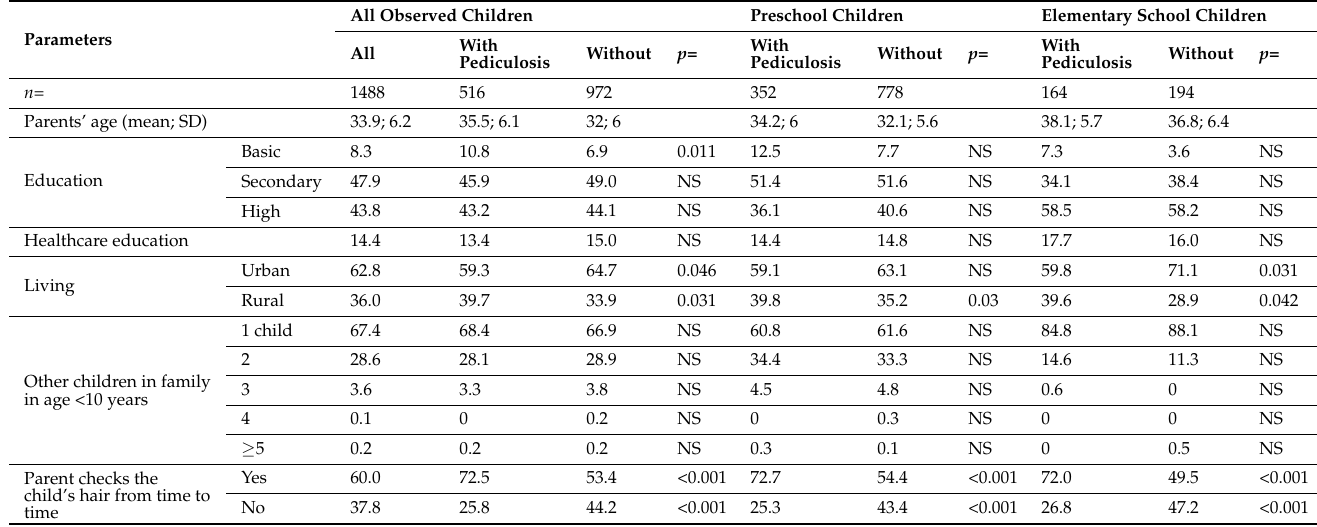
Table 1. Sociodemographic data and basic pediculosis prophylactic practices for all study participants.